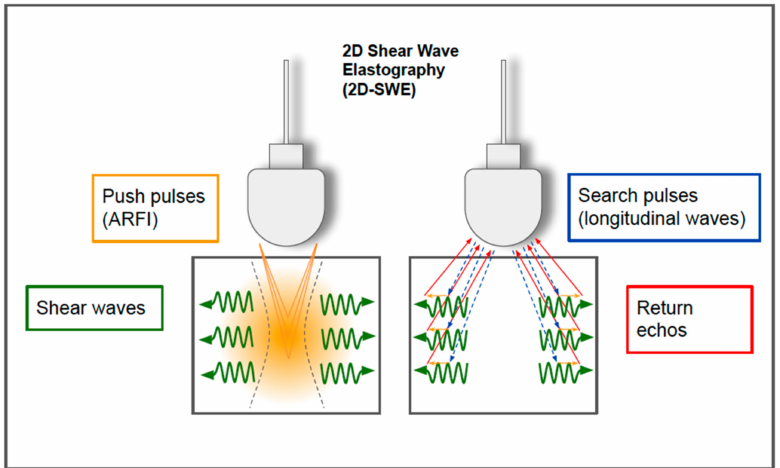
Figure 12. Two-dimensional shear wave elastography. In 2D-SWE, instead of a single focal location, as in ARFI strain imaging and pSWE, the acoustic radiation force is used to interrogate multiple focal zones in rapid succession, faster than the shear wave speed. In step 1 (on the left), shear waves are generated using acoustic radiation force impulses; they propagate perpendicularly to the primary US wave at a lower velocity. In step 2 (on the right), since the speed of sound in tissue is approximately 1000 times faster than the shear wave speed, fast longitudinal wave excitation (blue and red arrows) can be used to track the displacement (orange small arrows) as the shear waves propagate through the